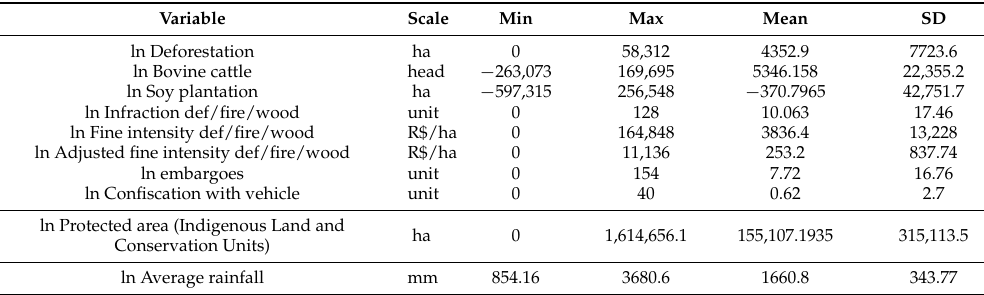
Table 5. Variables used in regression models.